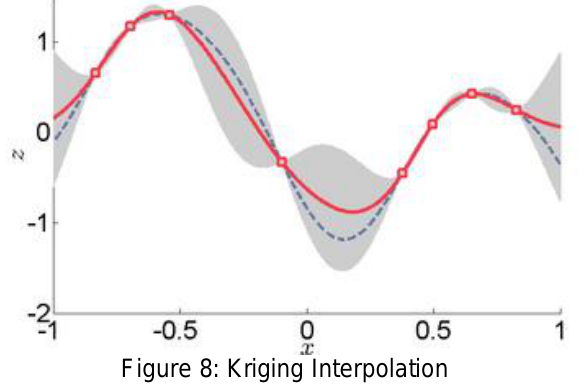
Figure 8: Kriging